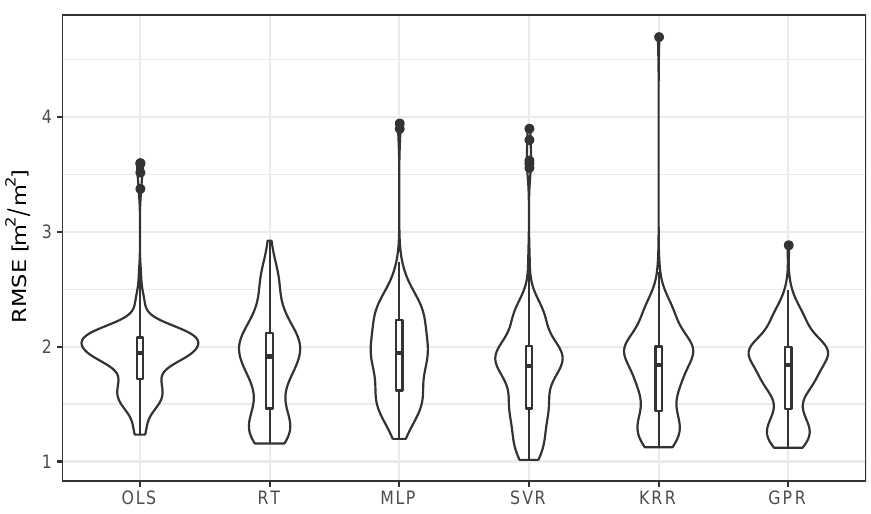
Figure 10. Violin plots [76] of prediction performance for the different MLRAs. It should be noted that 25 realisations were trimmed with RMSE larger than 5.0m 2 m − 2 (18 for OLS and 7 for KRR) because they prevented proper